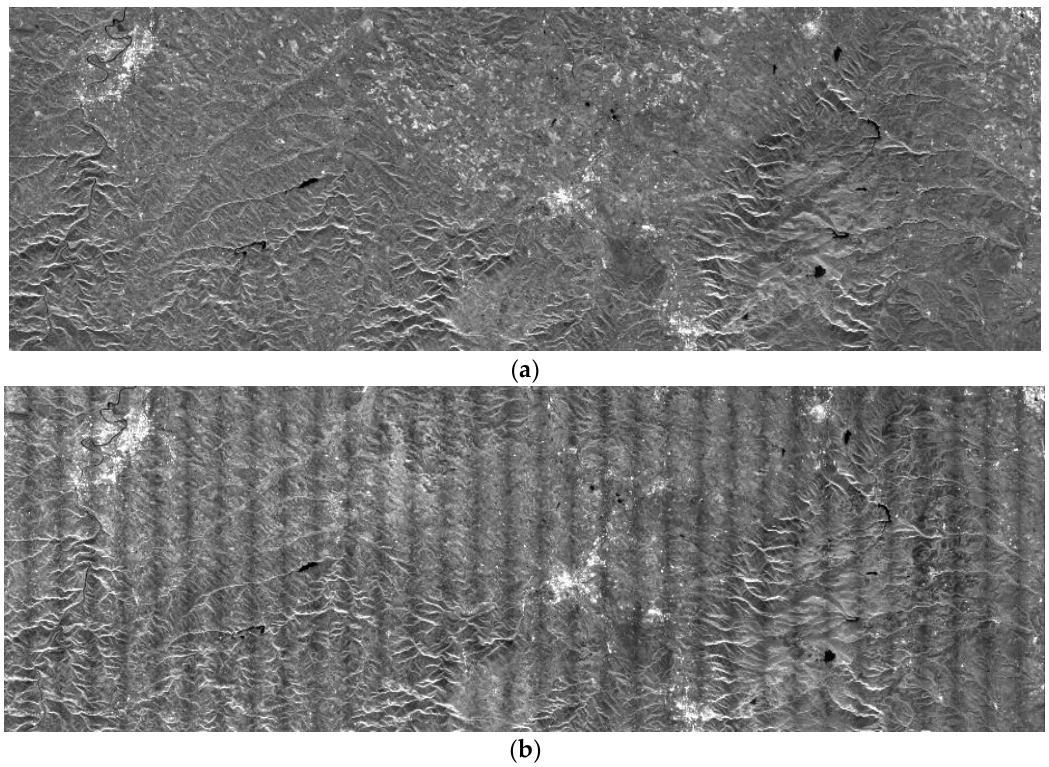
Figure 7. Terrain Observation with Progressive Scans SAR (TOPSAR) ( a ) and ScanSAR ( b ) comparison, both without scalloping correction. One sub-swath is shown. The measured scalloping in the ScanSAR image is around 1.2 dB, as compared to 0.3 dB in the TOPSAR image. Thirty-three ScanSAR bursts were necessary in contrast to only nine required in the TOPSAR mode.